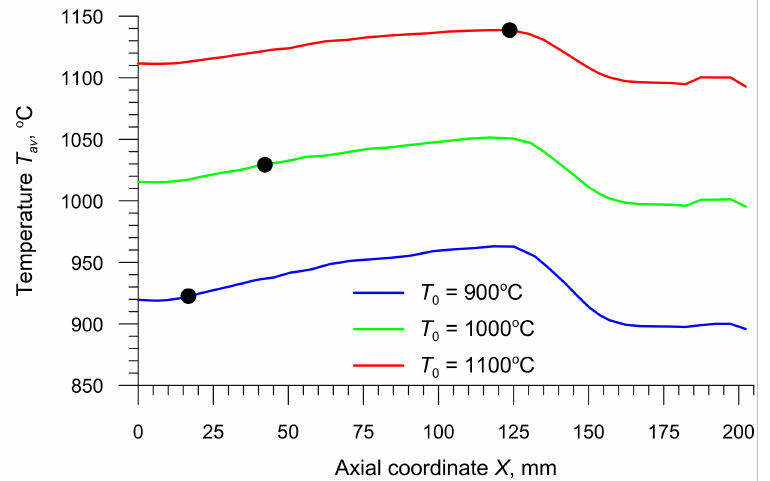
Figure 15. Average temperature in the axial zone of the specimen versus billet temperature T 0 ; the symbol “ • ” marks the location of fracture